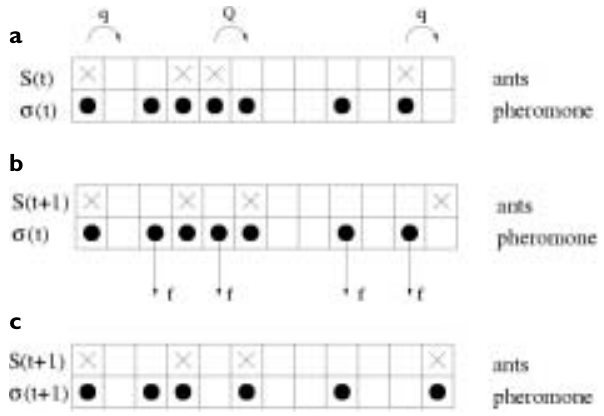
Figure 4 Schematic representation of typical configurations; it also illustrates the update procedure. (a) Configuration at time t , ie before stage I of the update. The non-vanishing hopping probabilities of the ants are also shown explicitly. (b) Configuration after one possible realisation of stage I. Two ants have moved compared with the top part of the figure. Also indicated are the pheromones that may evaporate in stage II of the update scheme. (c) Configuration after one possible realisation of stage II. Two pheromones have evaporated and one pheromone has been created due to the motion of an